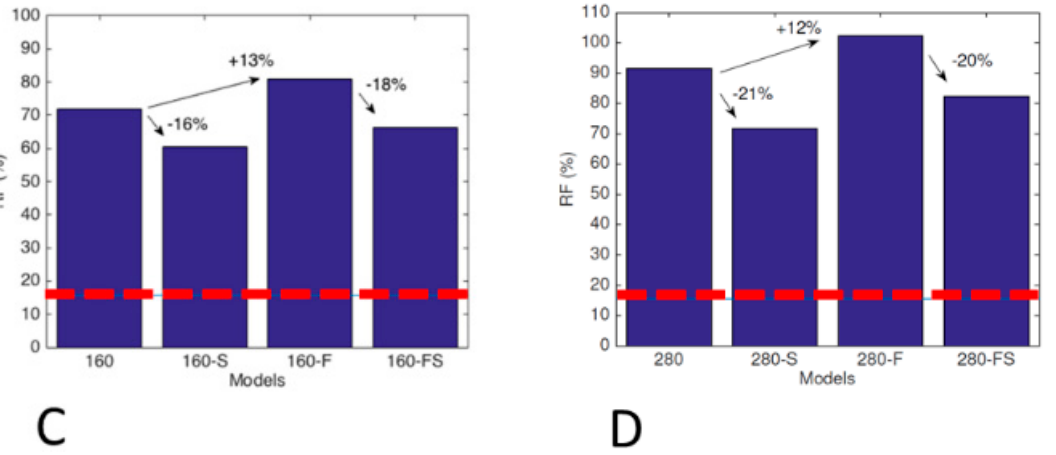
Figure 5. Risk of fracture for several configurations analyzed in the case of femoral stem: ( A ) 220 mm straight (220) and bowed (220B); ( B ) 280 mm straight (280) and bowed (220B); ( C ) stem of 160 mm straight (160), with slot (160 − S), fluted (160 − F), and fluted with slot (160 − FS); ( D ) stem of 280 mm straight (280), with slot (280 − S), fluted (280 − F), and fluted with slot (280 − FS).